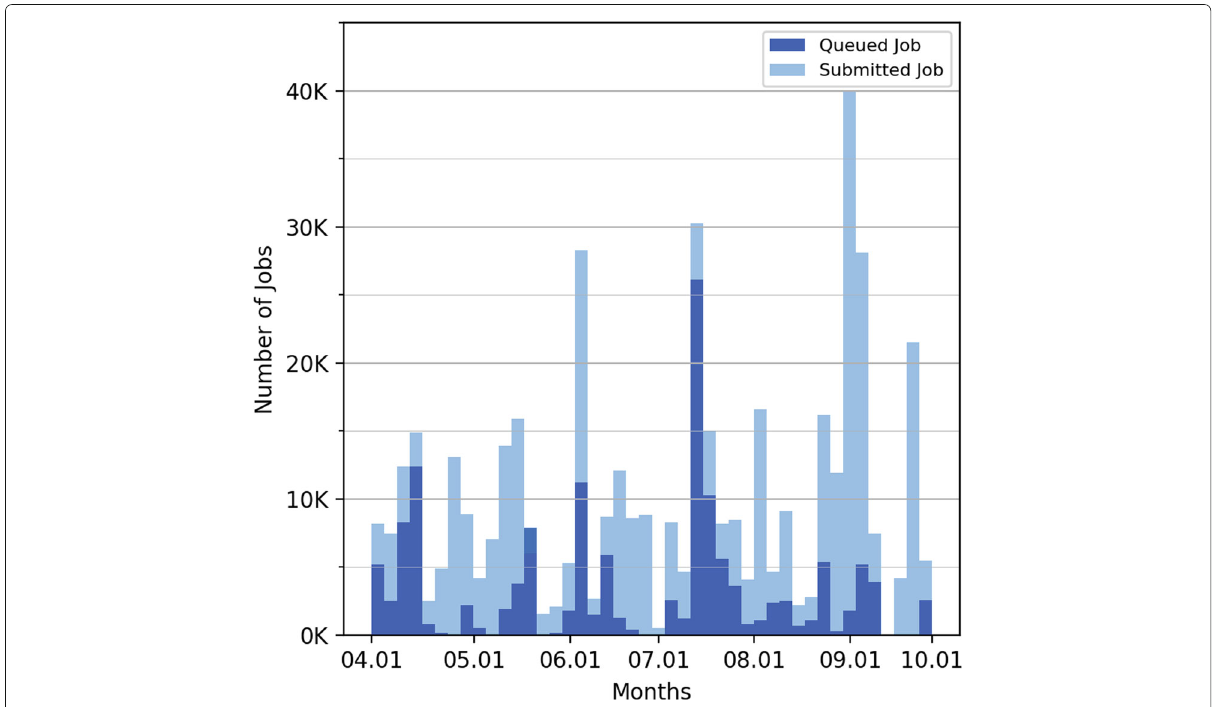
Fig. 6 Submitted and Queued Jobs in KIAF